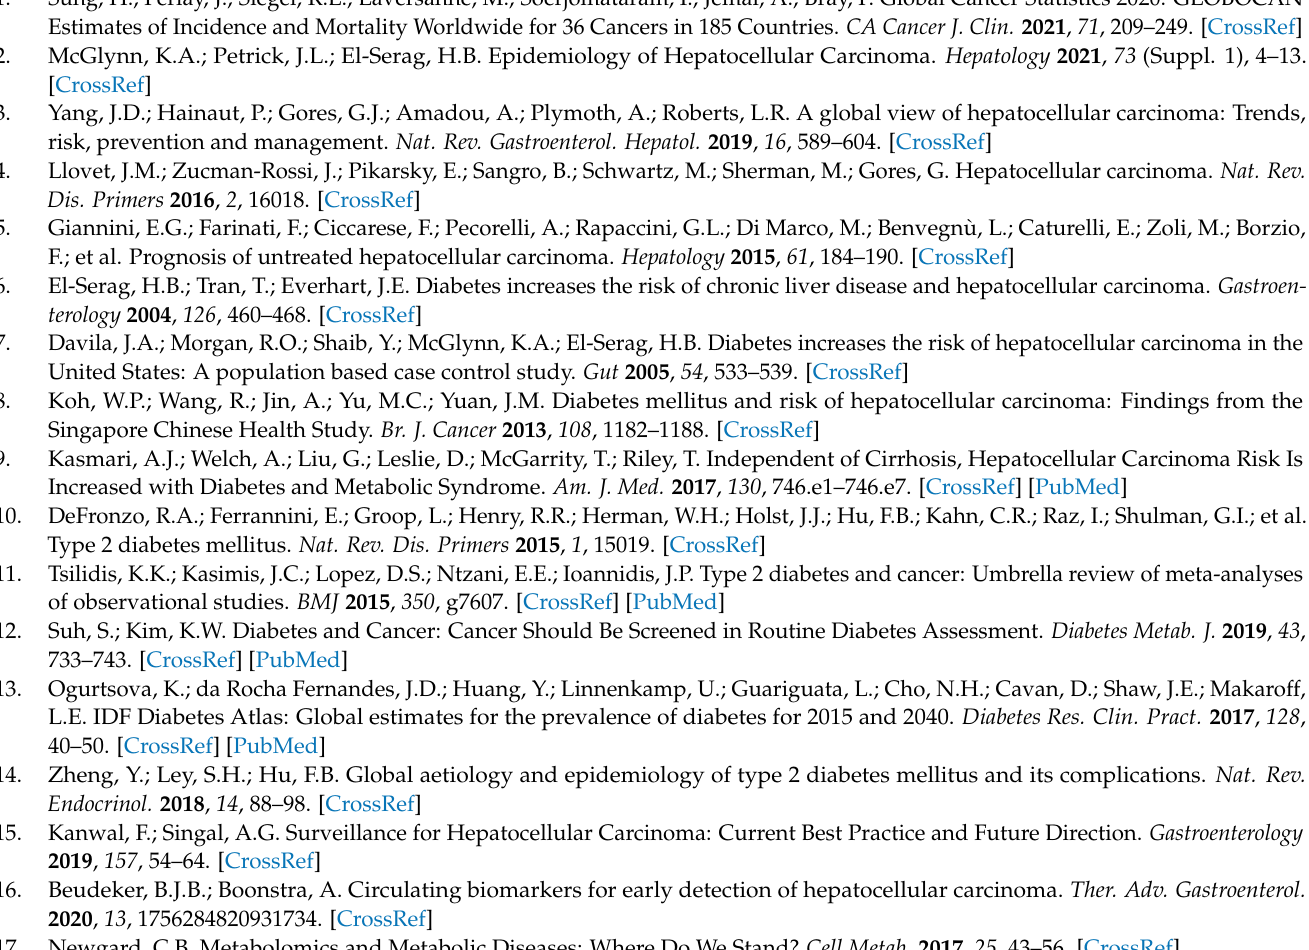
Table S3: The results of methodology validation for the quantification of serum benzoic acid, glyceric acid, creatine, L-threonine, and